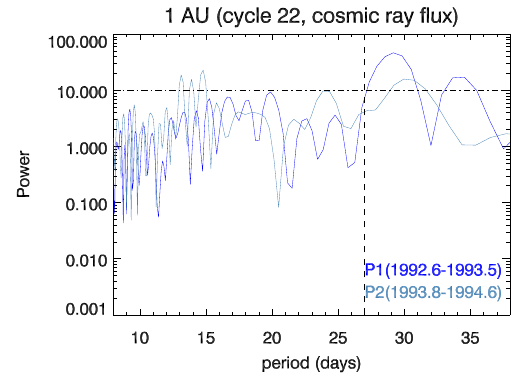
Fig. 9. Lomb periodograms for GCR measurements of the Moscow Neutron Monitor in the time interval C22. The representation is the same as in (the right panel of) Fig. 6. The vertical line indicates here the 27-day synodic period of the